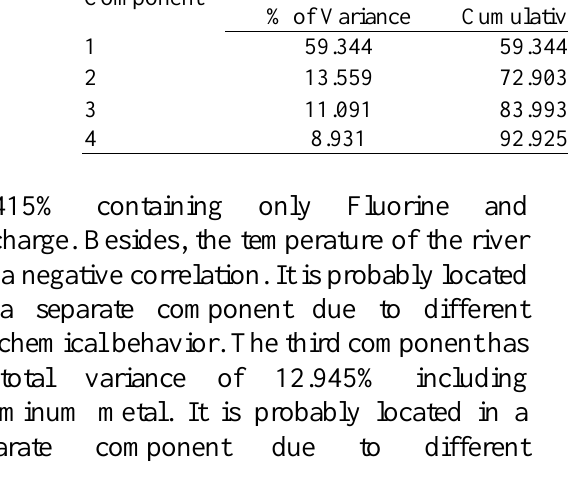
Table 7 Rotated component matrix of Silakhor River water samples Rotated Component